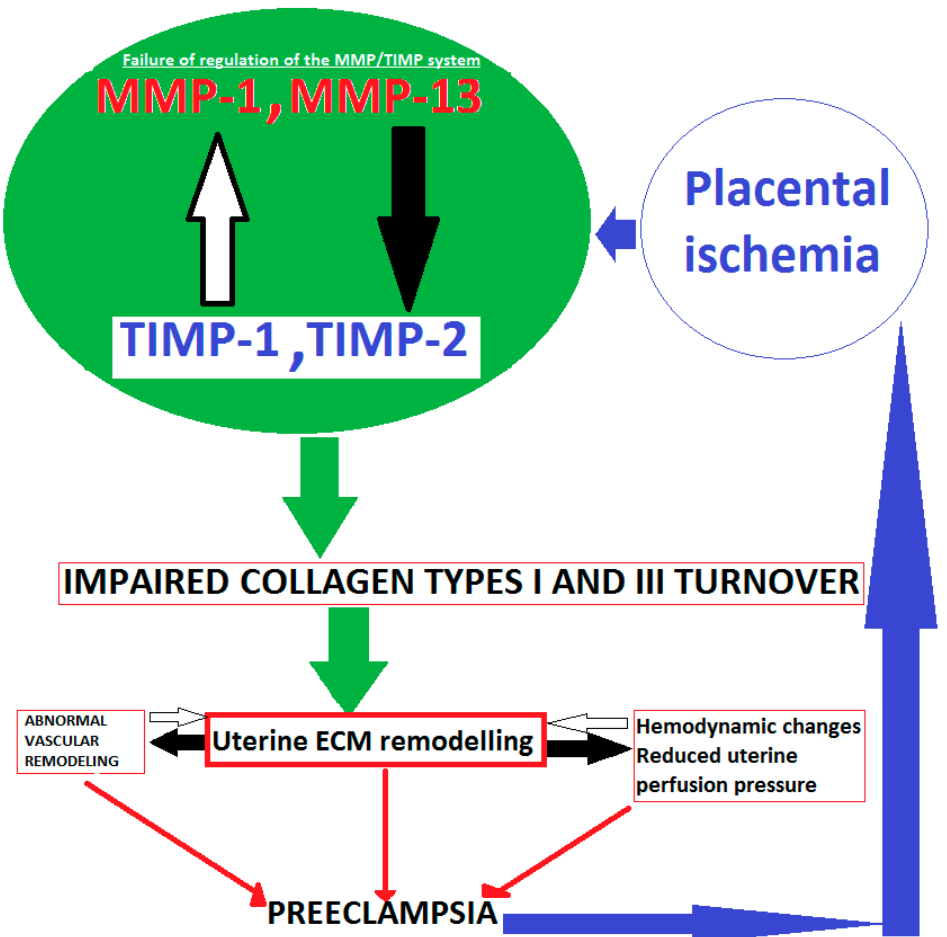
Figure 1. Schematic presentation of impaired collagen I and III turnover in pathological pregnancy.